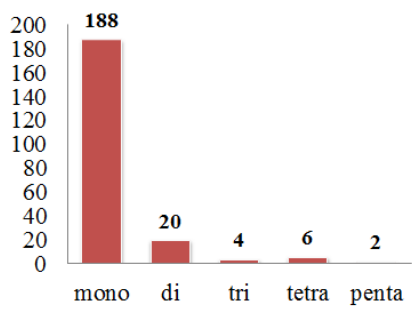
Figure 7. SSR distribution on the basis of repeat type. Y-axis represents the number of